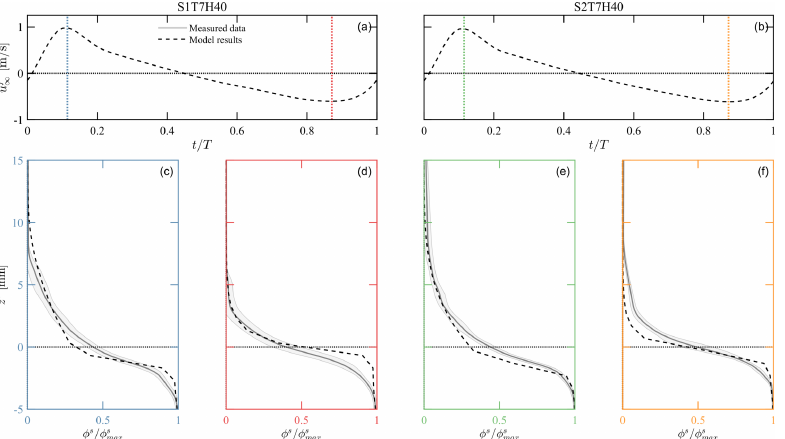
Figure 8. Time series of modeled free stream velocity for ( a ) S1T7H40 and ( b ) S2T7H40. ( c – f ) are mea- sured (gray solid curves, phase-averaged; gray envelopes, ± 1 standard deviation) and modeled (black dashed curves) vertical profiles of normalized volumetric sediment concentration, φ s / φ s max ( z ∗ , t / T ) , under ( c , e ) the wave crest ( t / T = 0.114) and ( d , f ) wave trough ( t / T = 0.871), as denoted in ( a , b ) using vertical dotted lines with corresponding